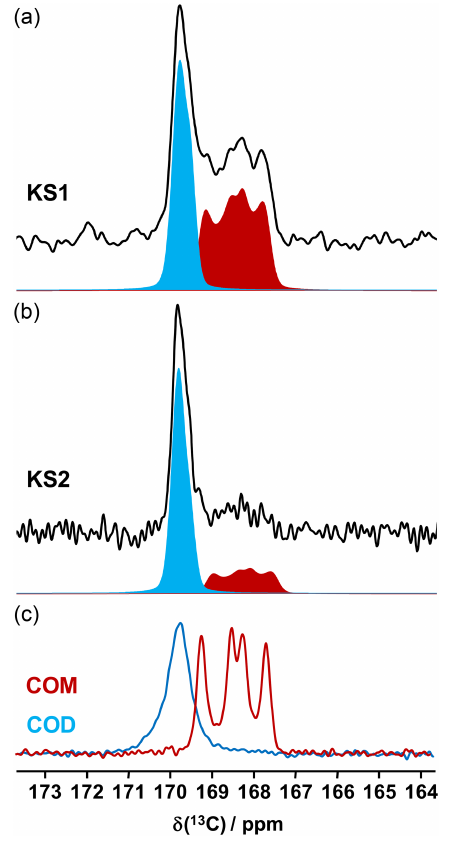
Figure 7. 13 C CP MAS NMR spectra of (a) KS1 and (b) KS2 (recorded at 16.4T, ν rot = 5kHz) and the corresponding COM (red) and COD (blue) contributions. (c) 13 C CP MAS NMR spectra of the synthetic COM (red line) and COD (blue line) recorded under similar